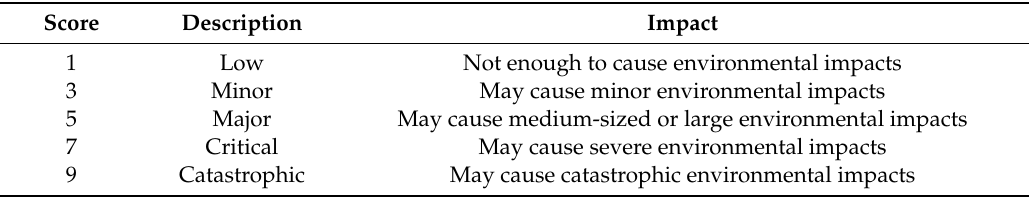
Table 7. Environmental Impact Scores and